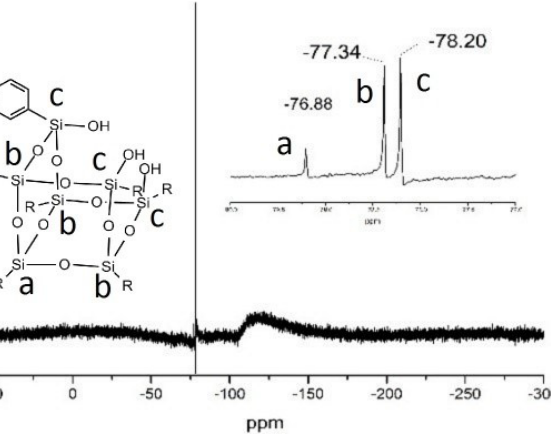
Figure 7: 29 Si NMR spectrum of heptamertic phenyl silsesquioxane trisilanol(POSS-triol)